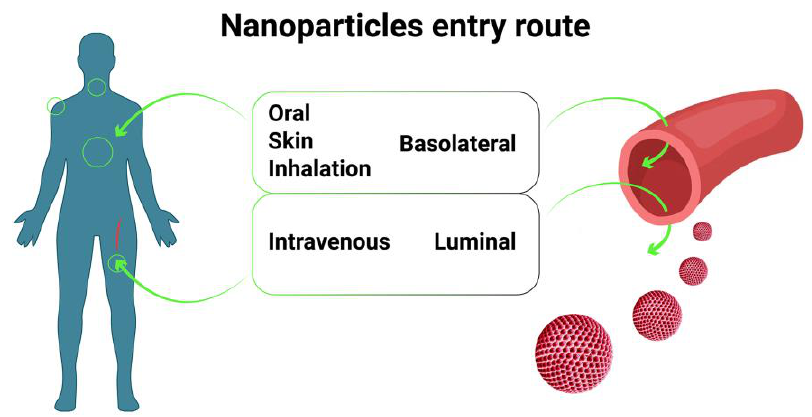
Figure 1. Main routes of NP entry into organisms. Most NPs can enter the body through natural barriers, such as the skin, mucous membranes, or vessel walls. At the same time, to study the biodistribution of NPs, it is important to understand how nanoparticles pass through these barriers. For example, NPs that enter the body through the skin can enter vessels by passing through the basolateral membrane and then through the endothelial layer. If the NPs initially enter the vessel, they can leave it via the luminal pathway, first passing the endothelial layer and then the basolateral membrane in the opposite direction.